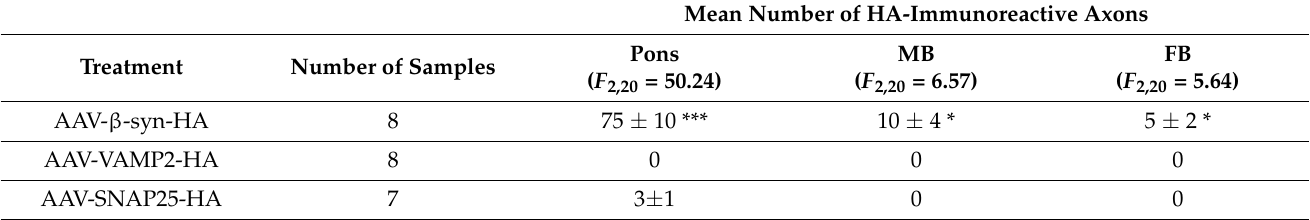
Table 1. Counts of HA-positive axons in predefined sections of the pons, midbrain, and forebrain. Mean Number of HA-Immunoreactive Axons Treatment Number of